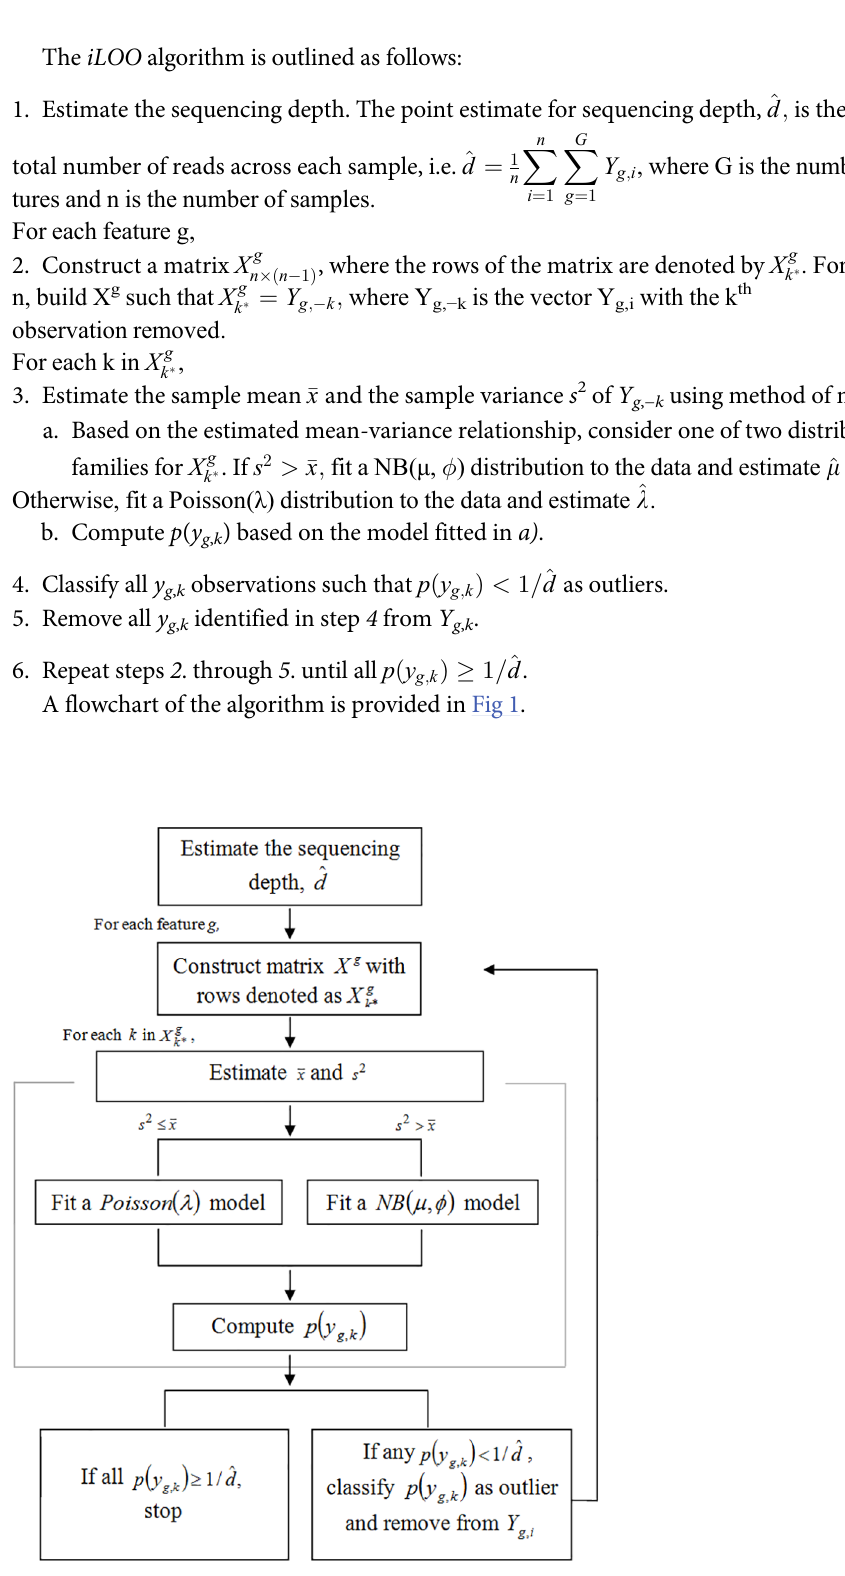
Fig 1. Flowchart of the iLOO